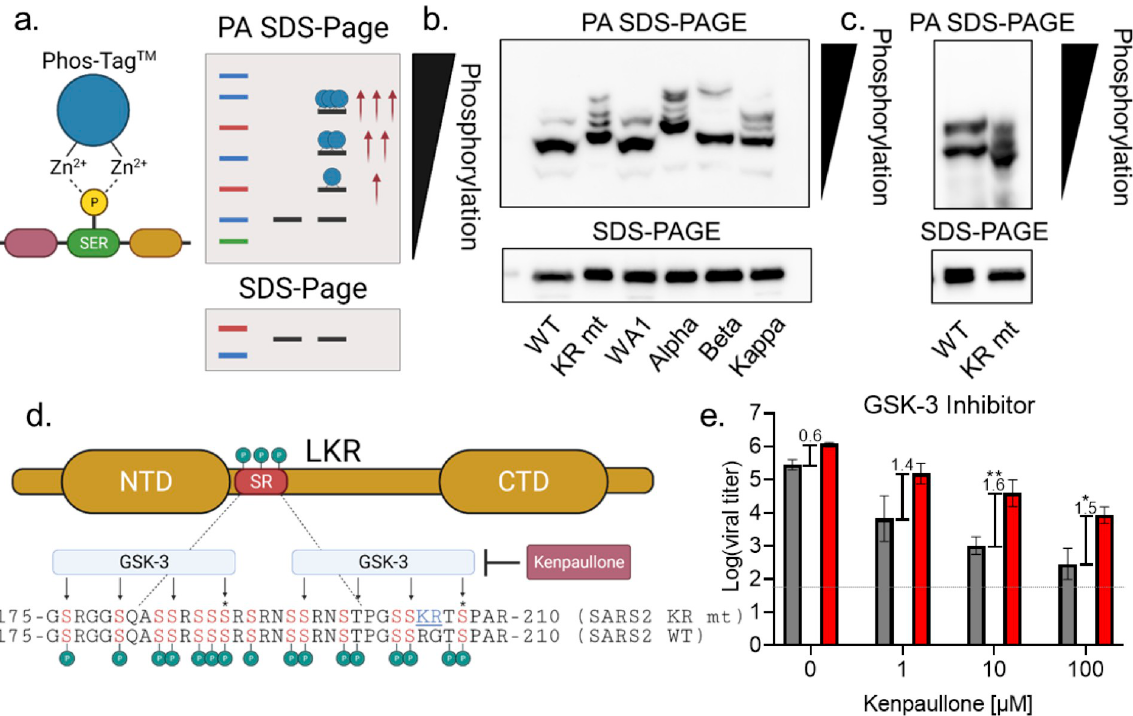
Fig 6. The KR mt increases N phosphorylation to enhance infection. ( A ) Schematic of phosphate-affinity (PA) SDS-PAGE. ( B ) Whole cell lysates from Calu-3 2b4 cells infected with SARS-CoV-2 WA-1-mNG (WT), the KR mt, WA-1, alpha, beta, and kappa variants were analyzed by PA SDS-Page (top) or standard SDS-PAGE (bottom) followed by blotting with an N-specific antibody (n = 3). ( C ) Whole cell lysates from Vero E6 cells infected with WT or the KR mt and analyzed by PA-SDS-Page (top) or standard SDS-Page (bottom) followed by blotting with an N- specific antibody (n = 3). ( D ) Schematic of phosphorylation by GSK-3 of the SR domain of SARS-CoV-2 N. Residues targeted by GSK-3 are indicated with arrows and priming residues designated by a ‘ � ’. ( E ) Viral titer 48 hours post infection from Calu-3 2b4 cells infected with WT SARS-CoV-2 (gray) or the KR mt (red) at an MOI of 0.01. Cells were treated with the indicated concentrations of kenpaullone 1 hour prior to and during infection. Brackets and numbers indicate the mean log-titer difference between WT and the KR mt. Bars are the mean titer ± s.d. (n = 4). Significance indicates a change in mean titer difference compared to untreated cells and was determined by student’s T-Test with p � 0.05 ( � ) and p � 0.01 ( �� ). Schematic in (A) and (D) generated using